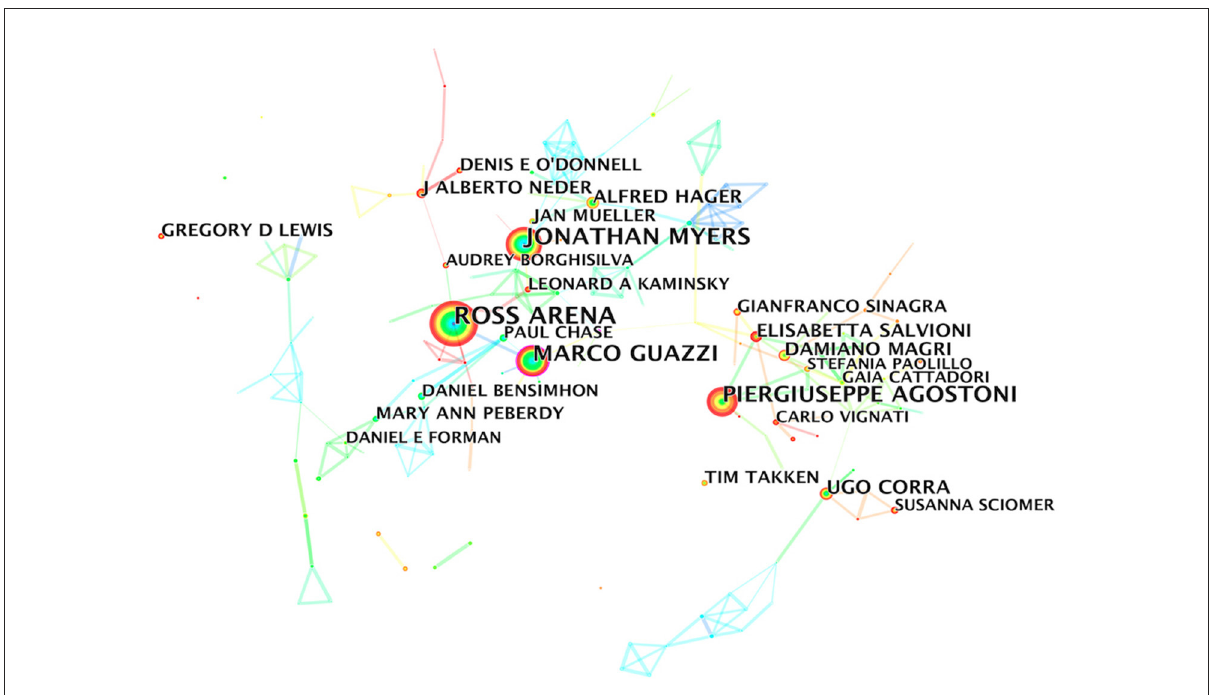
FIGURE4 Author collaborative network